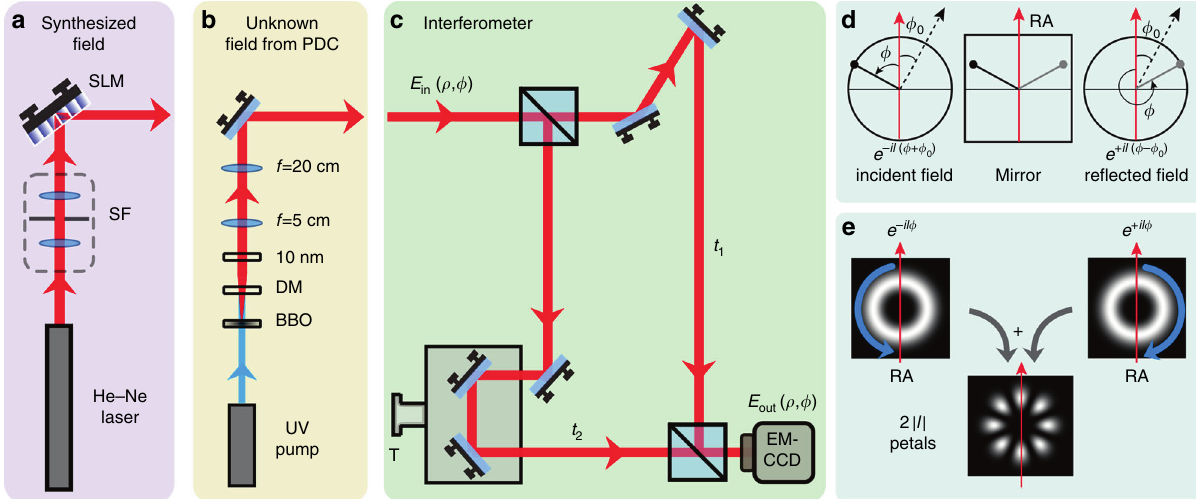
Fig. 1 Describing the proposed experimental technique and its working priciple. a Schematic of the setup for synthesizing partially coherent fi elds of the type represented by Eqs. (1) and (2) with known OAM spectra. b Schematic of the setup for producing the partially coherent fi elds through parametric down-conversion. c Schematic of the Mach – Zehnder interferometer. d Describing how a mirror re fl ection changes the azimuthal phase of an OAM mode. An incident beam with the azimuthal phase pro fi le e il ϕ þ ϕ 0 ð Þ transforms into a beam having the azimuthal phase pro fi le e (cid:5) il ϕ (cid:5) ϕ 0 ð Þ , where ϕ 0 is the angle between the re fl ection axis (RA) and the zero-phase axis (dashed axis) of the incident mode. e Illustrating the interference effect produced by the ð ρ ; ϕ Þ mode with l = 4. At the output, we effectively have the interference of an e il ϕ mode with an e − il ϕ interferometer when the incident fi eld is an LG l p ¼ 0 mode, and we obtain the output interference intensity in the form of a petal pattern with the number of petals being 2 l j j = 8. SLM: spatial light modulator; SF: spatial fi lter; DM: dichroic mirror; BBO: type-I beta barium borate crystal; T: translation